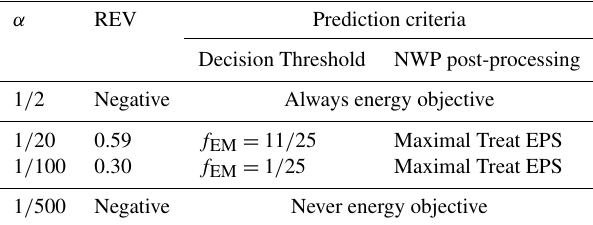
Table 5. Decision threshold and REV for the theoretical 4 α -values considered, using the maximal threat post-processing